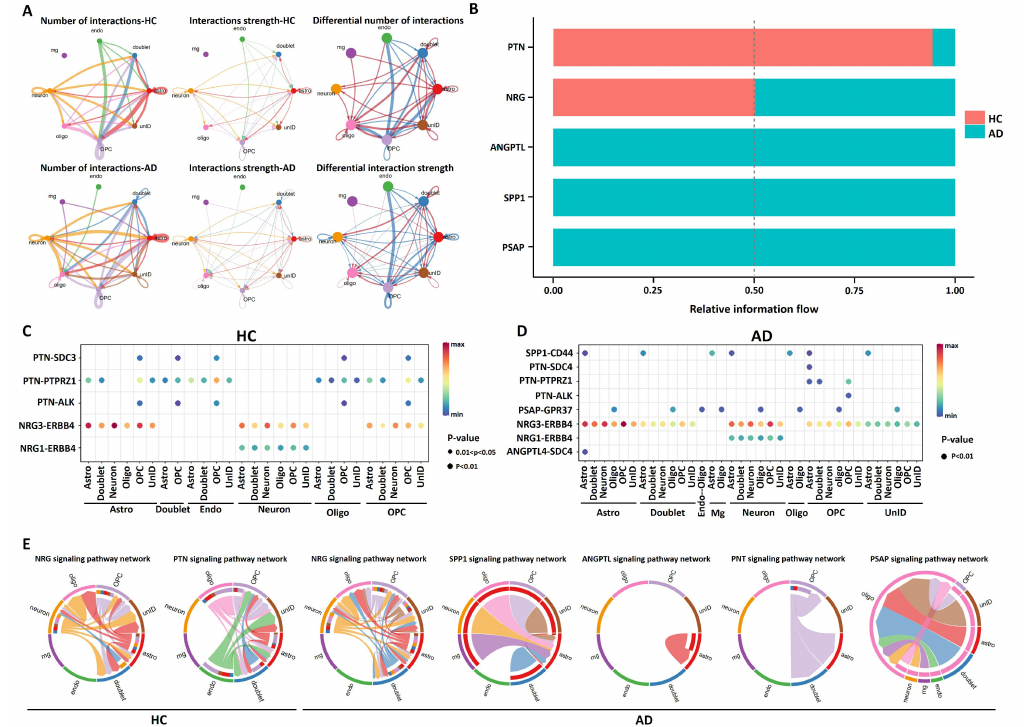
Figure 3. Intercellular ligand–receptor prediction. ( A ) Number and strength of interactions between AD and controls. ( B ) Histogram of proportion of PTN, NRG, ANGPTL, SPP1, and PSAP pathways between AD and HC. ( C ) Dot plot of interactions between cell types in controls. ( D ) Dot plot of interactions between cell types in AD. ( E ) Chord diagrams of intercellular communication between signaling pathways. HC: healthy controls. AD: Alzheimer’s disease. Astro: astrocytes. UnID: unidentified cells. Oligo: oligodendrocytes. Endo: endothelial cells. Mg: